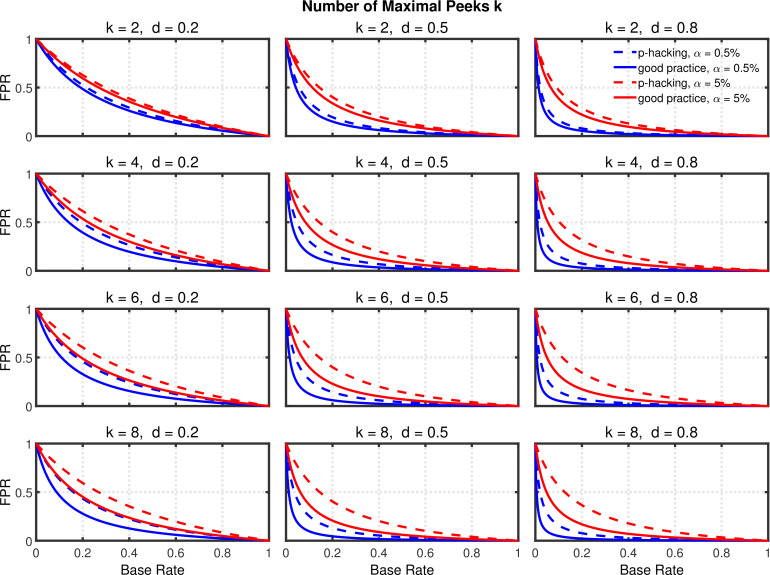
Data peeking.False positive rate (FPR) as a function of base rate π, number of maximal data peeks k, and nominal α level (0.5% or 5%). The nominal α level and power of the replication study are α2=0.05 and 1-β2=0.90. Dashed lines give the results for p-hacking whereas solid lines depict the results of researchers who act in accord with good scientific practice. Note that the solid lines are the same in all rows of a single column because these constant reference lines do not depend on k.